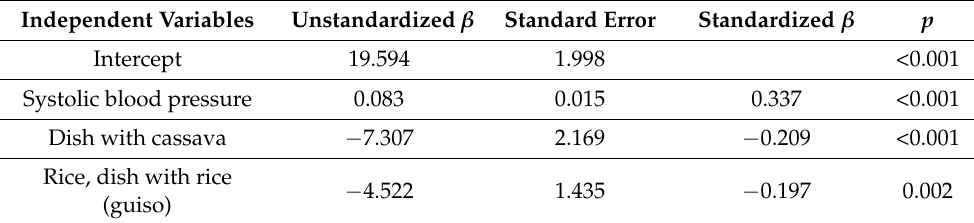
Table 4. Variables selected via best subset selection in multiple regression analyses for females. Independent Variables Unstandardized